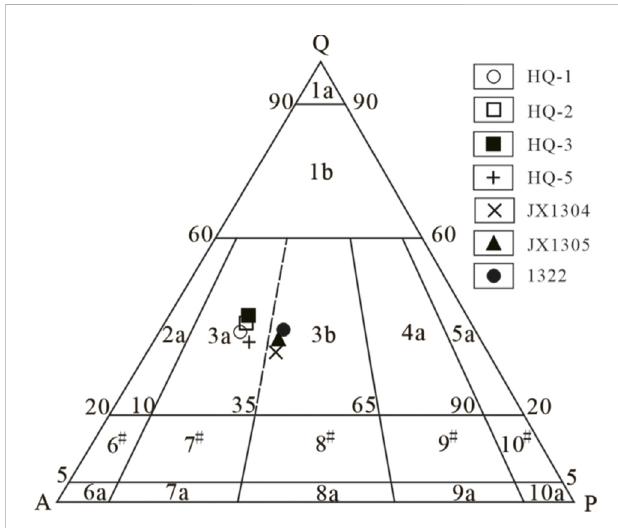
FIGURE 8 QAP diagram of granites in the Xinchenggou area, NE China (after Streckeisen,1976).1a-Quartzolite;1b-Quartz-richgranitoid;2a-Alkali- feldspar granite; 3a-Syenogranite; 3b-monzogranite; 4a-Granodiorite;